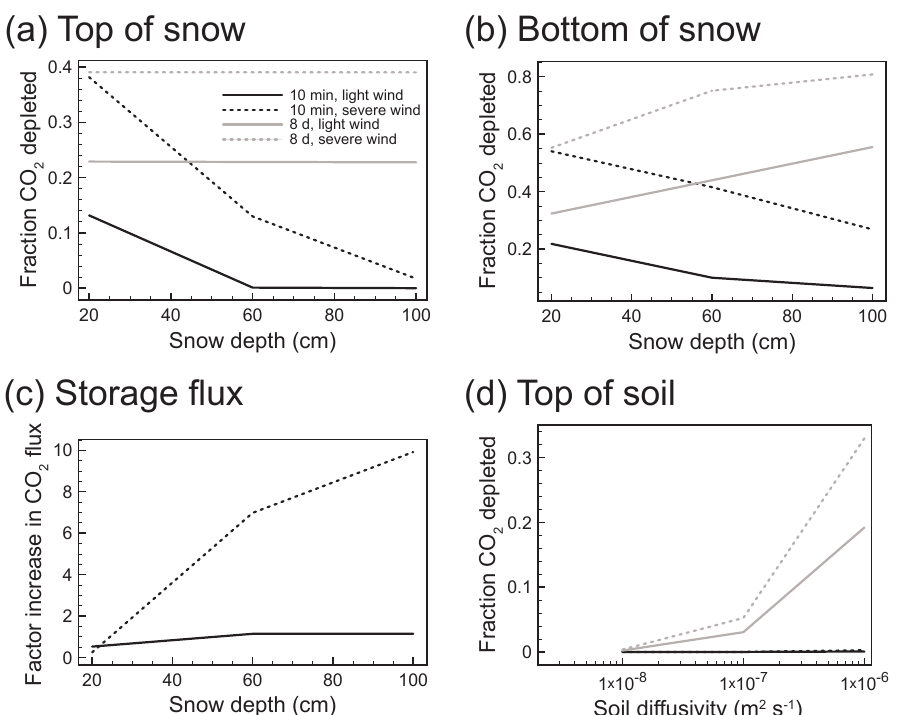
Figure 6. (a) Modelled results at top of snowpack shown as the fraction of CO 2 concentration depleted from the snowpack. (b) Modelled results at bottom of snowpack shown as the fraction of CO 2 concentration depleted from the snowpack. (c) Modelled storage flux, shown as factor increase in short-term CO 2 flux. Scenarios at equilibrium (8 days) were incalculable (not shown), as there was no change in CO 2 concentration once equilibrium was reached. (d) Modelled CO 2 at the topmost soil layer, shown as the fraction of CO 2 concentration depleted from the snowpack. There was very minimal effect on the fraction of CO 2 depletion for immediate scenarios (10min), and so there is significant overlap of the two 10min scenarios (light wind and severe